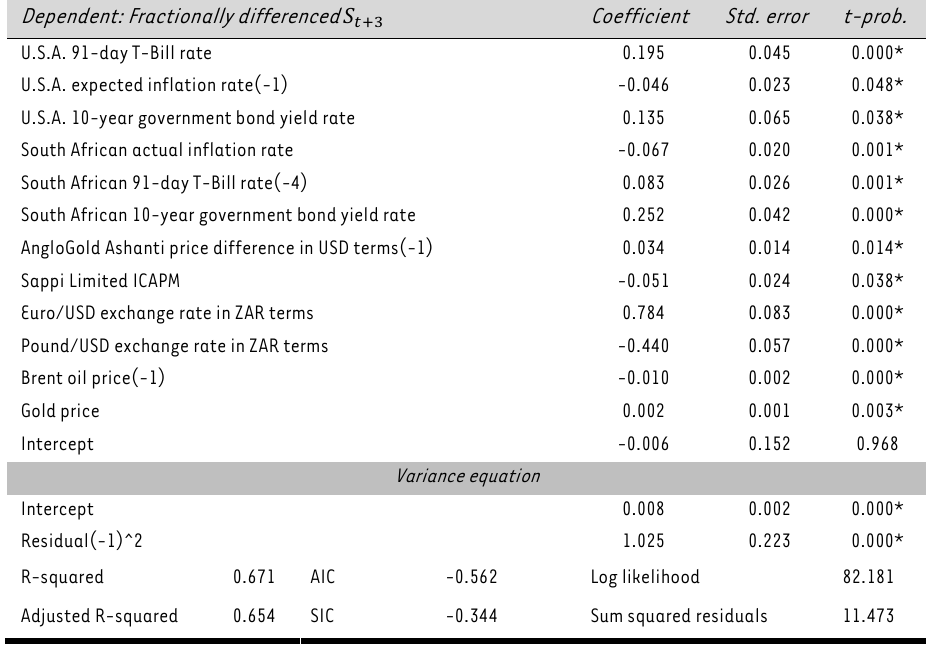
The ARCH(1,0) comparison with a dummy – fractionally differenced approach Dependent: Fractionally differenced Coefficient Std. error t-prob. 𝑆 𝑡+3